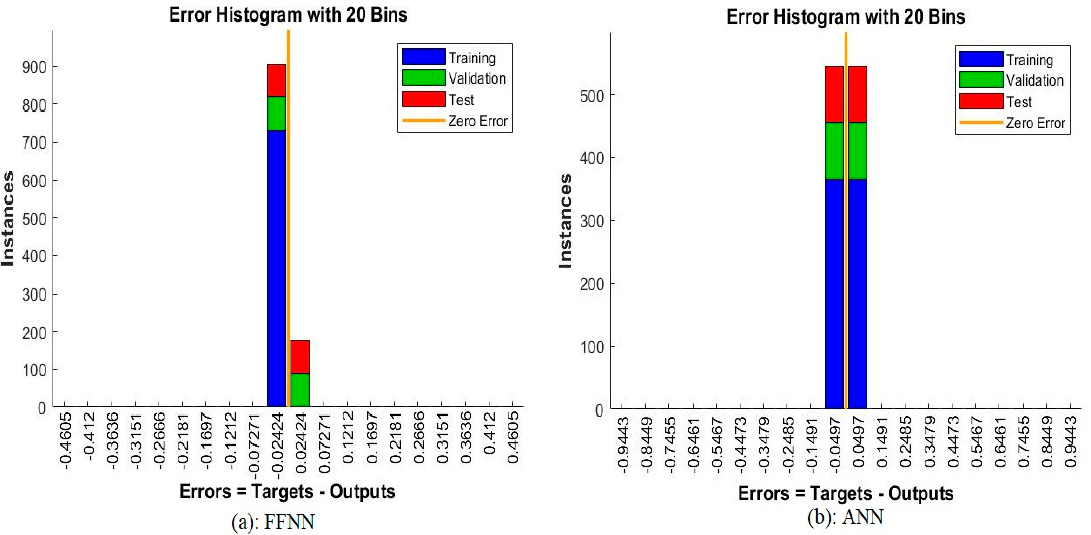
Figure 15. Error histogram of ASD dataset. ( a ) FFNN algorithm and ( b ) ANN algorithm.